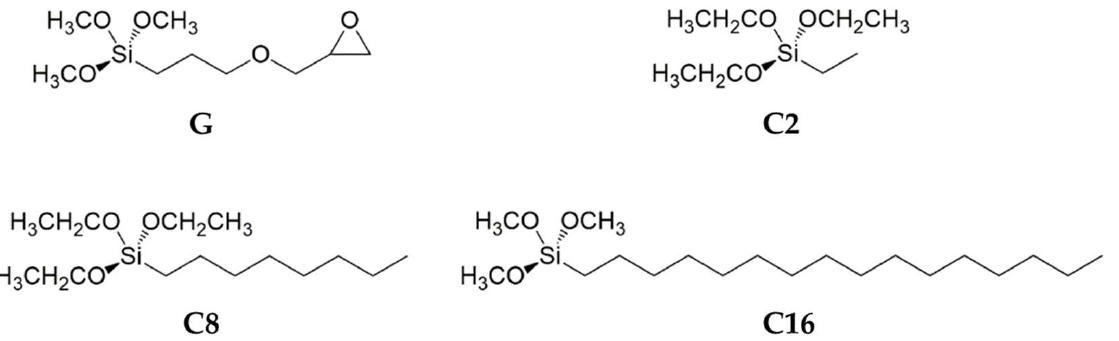
Figure 2. Alkyl(trialkoxy)silanes employed in this work.